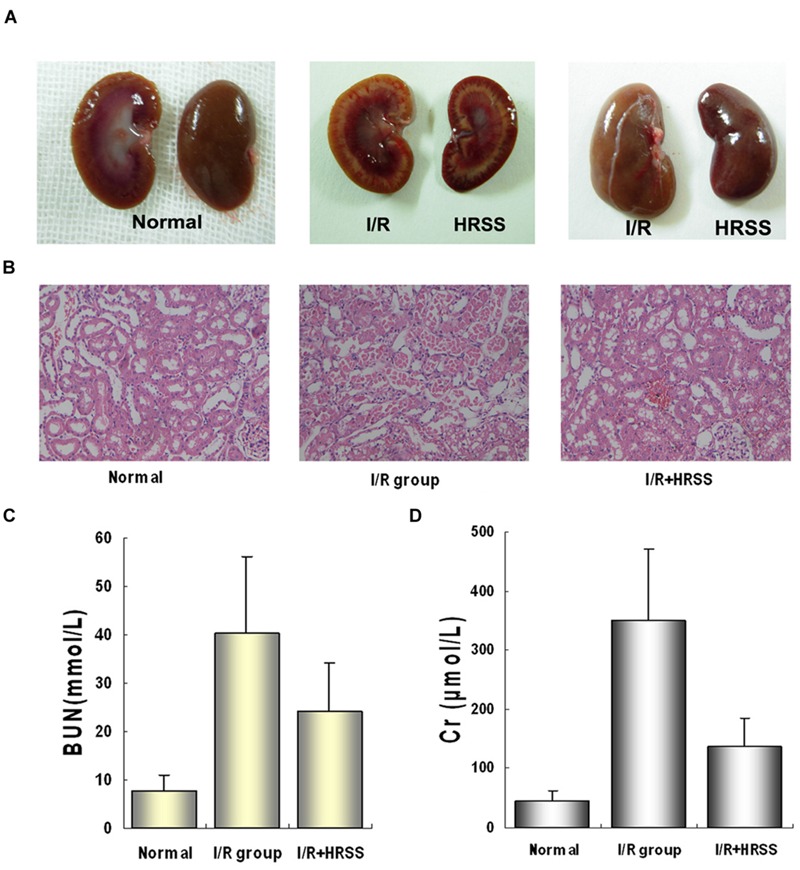
Alterations in renal morphology and function before and after renal I/R injury with and without hydrogen-rich saline solution (HRSS) treatment. (A) Kidneys gross structure. (B) Histological examination by H&E staining (×100). (C) Renal function at 24 h after I/R injury with and without HRSS treatment. (D) Creatine (Cr) and (C) blood urea nitrogen (BUN) were significantly reduced in HRSS-treated kidneys (P < 0.01).